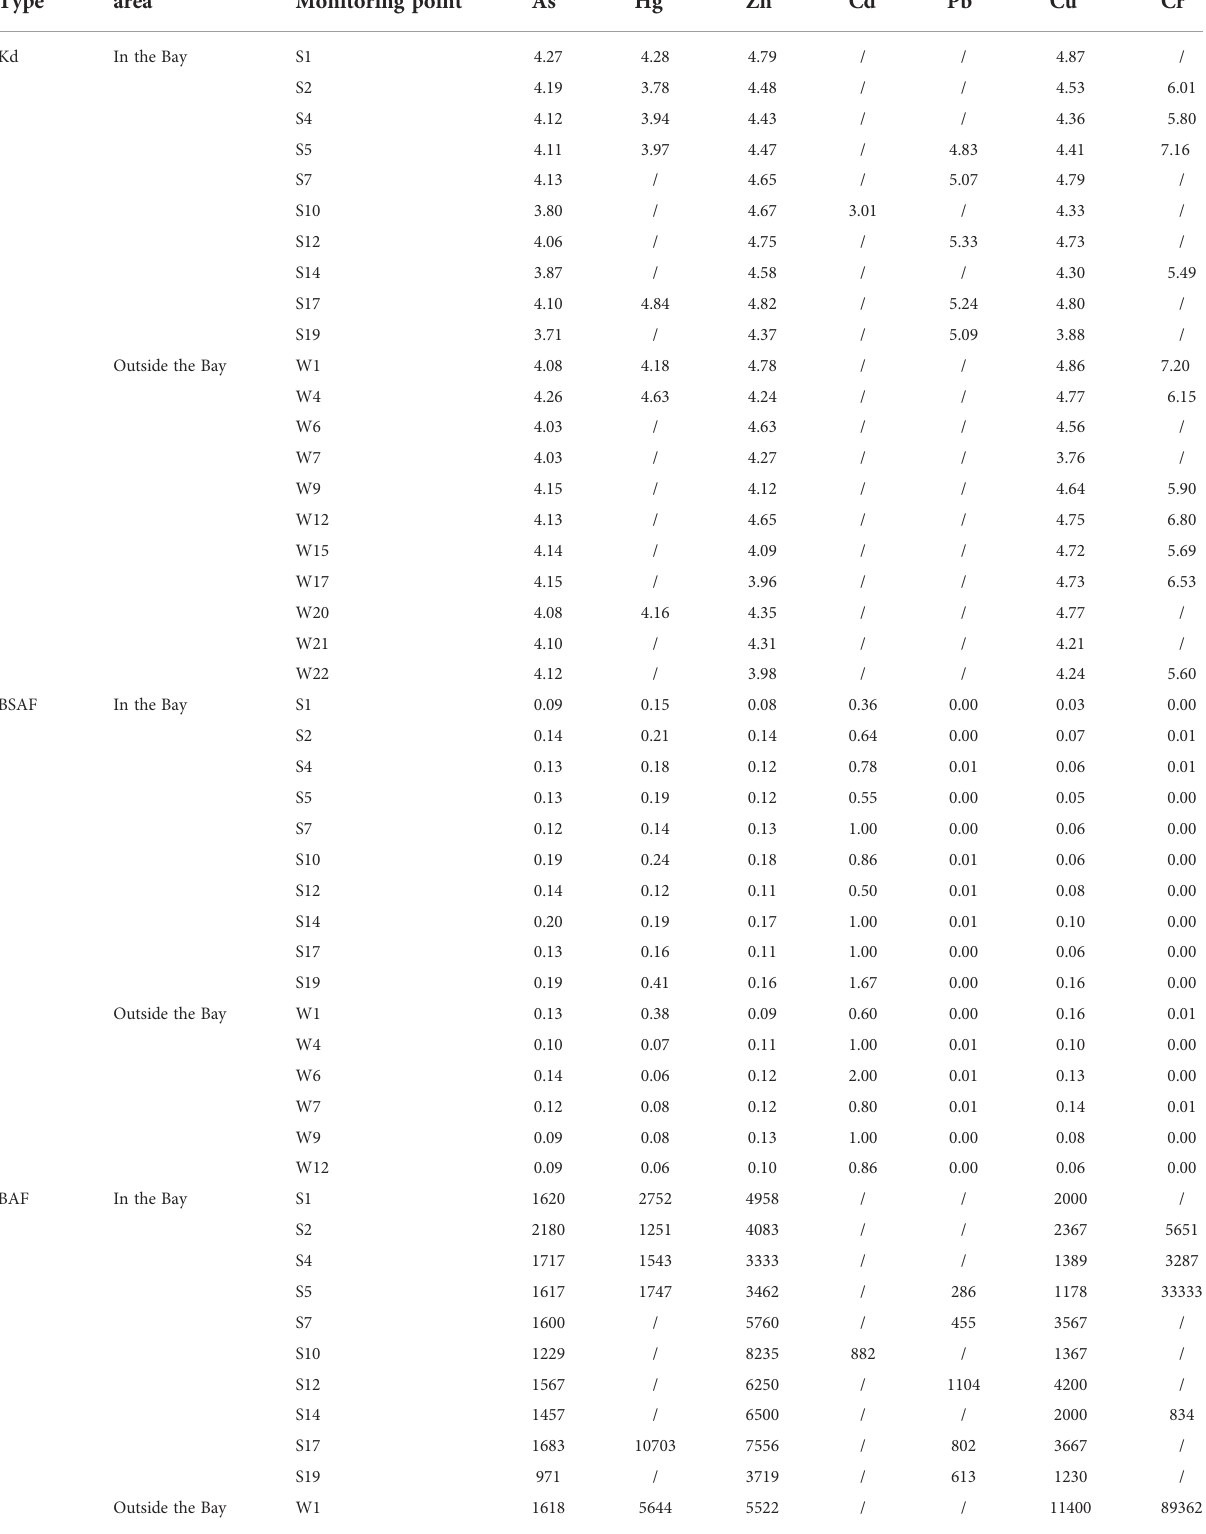
TABLE 7 Heavy metal enrichment capacity of marine organisms in Daya Bay. Type Kd In the Bay